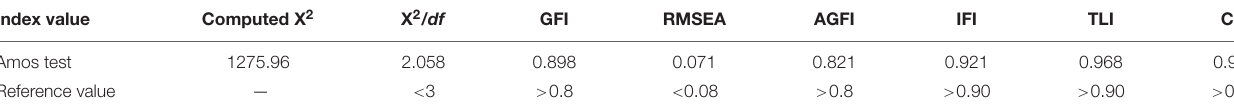
TABLE 8 | Evaluation of modified model fitting.